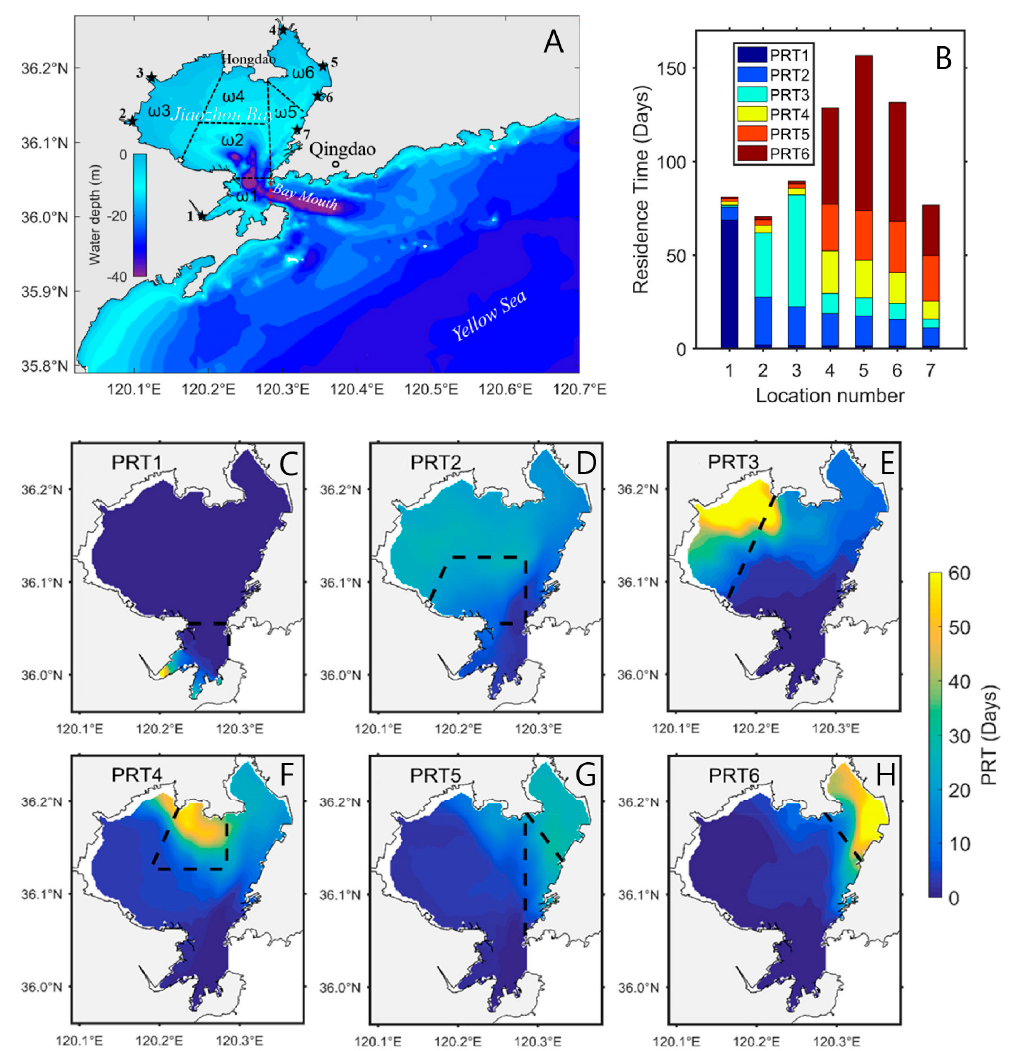
Figure 11. Lin and Liu’s [141] ( A ) bathymetry map of Jiaozhou Bay (China), showing six subregions ( ω 1 – ω 6 ) in which partial residence times (PRTs) were calculated in ( B – H ), and seven release points (stars) for which PRTs in the subregions are shown in ( B ). ( B ) For particles initiated at each of seven locations, PRTs shown are time spent in each of six subregions before leaving the bay. For a given release location, the sum of the PRTs equals the total residence time within Jiaozhou Bay. ( C – H ) Spatial maps for each subregion representing time spent in the subregion for particles initiated at every location in the domain. Dashed lines represent the boundaries of each subregion. (Adapted by permission from Springer Nature Customer Service Center GmbH: Springer Nature, Ocean Dynamics, Partial residence times: determining residence time composition in di ff erent subregions, Lin and Liu, 2019. https: // www.springer.com / journal /